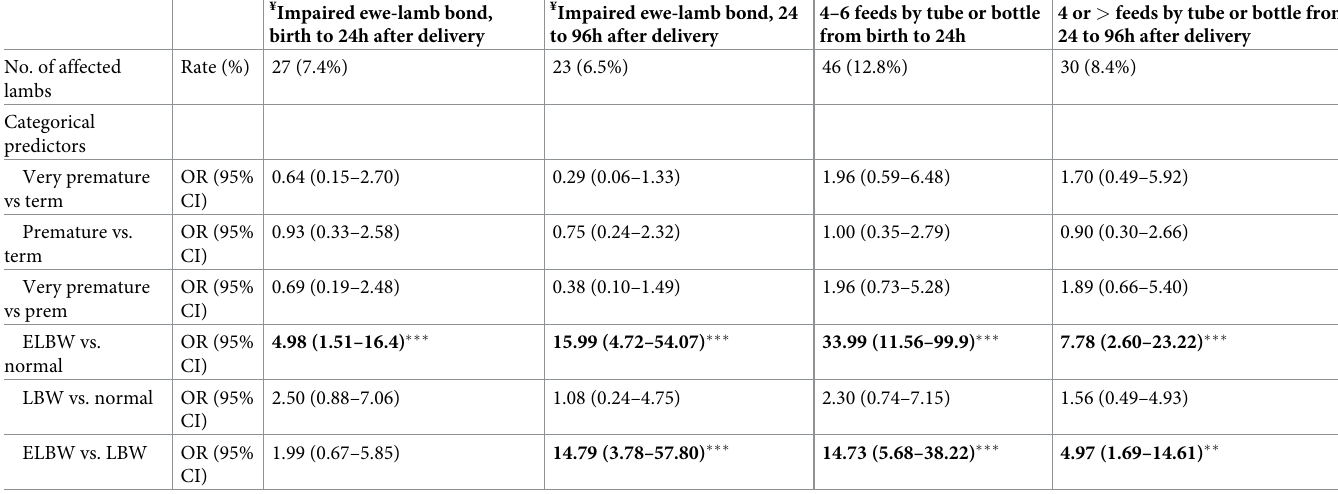
Table 5. Risk of an impaired ewe-lamb bond and likelihood of requiring supplementary feeding during the neonatal period in relation to delivery and birthweight category. ¥ Impaired ewe-lamb bond,